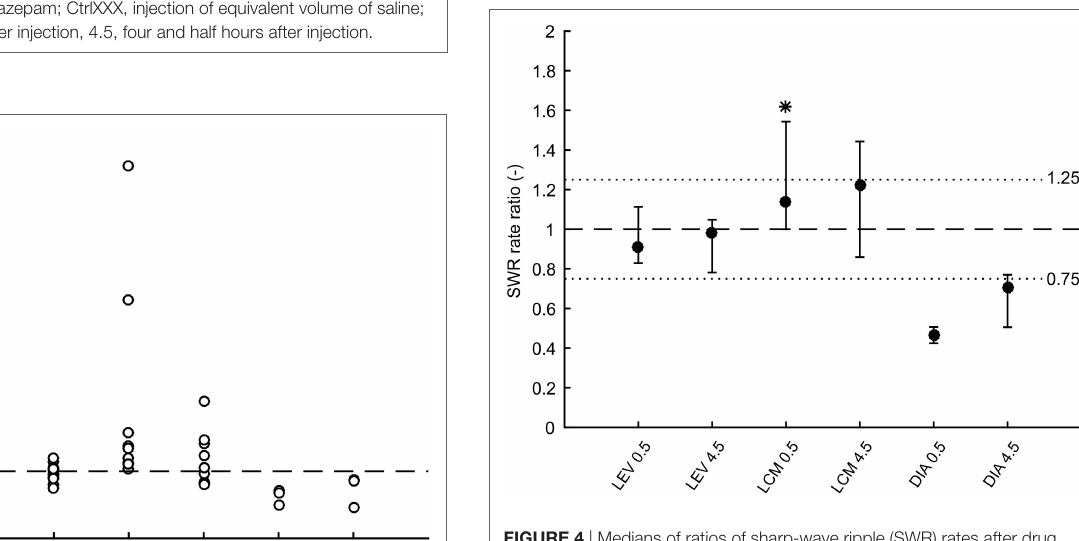
FigUre 4 | Medians of ratios of sharp-wave ripple (SWR) rates after drug injection to rates after corresponding saline injection. Error bars represent non-parametric confidence intervals of the medians. Dashed line is at value 1 which constitutes no effect. Dotted lines at values 0.75 and 1.25 represent equality margins. LEV confidence intervals are at 96% confidence and do not cross the equality margins. LCM significantly increases SWR rate 0.5 h after administration, but 4.5 h after administration the effect dissipates. Confidence intervals are 93%. DIA markedly reduces SWR rate 0.5 h after administration and 4.5 h after administration the effect slowly dissipates. Confidence intervals are 75%. LEV, levetiracetam; LCM, lacosamide; DIA, diazepam.